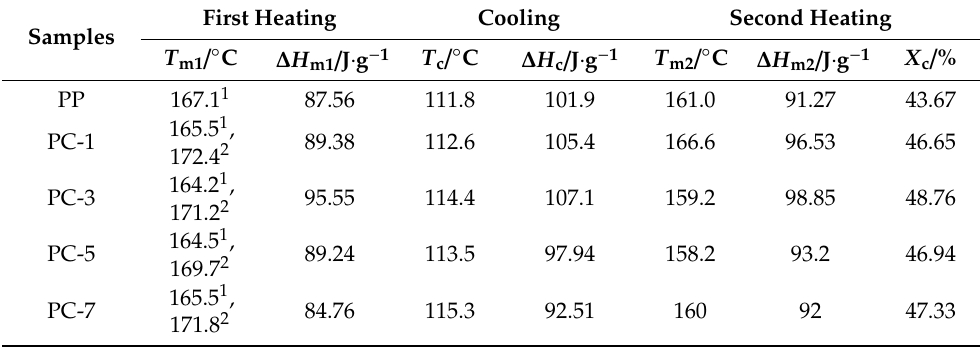
Table 3. Thermal properties of the